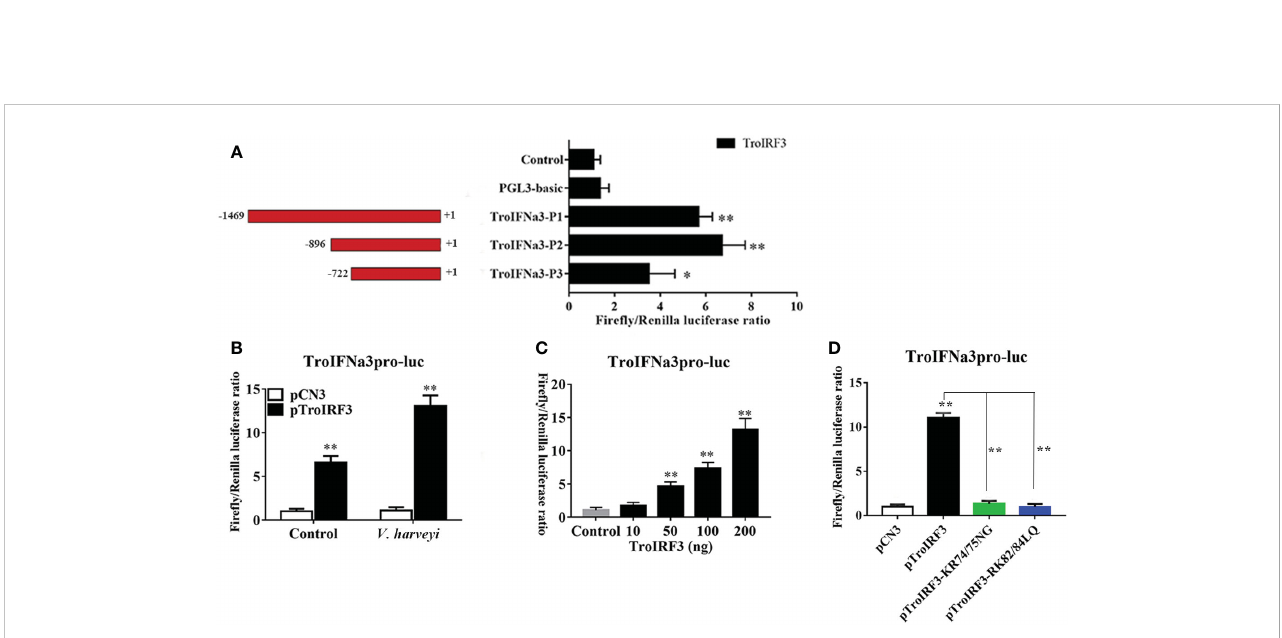
FIGURE 8 TroIRF3 regulated the activity of the TroIFNa3 promoter. (A) Three truncates of the TroIFNa3 promoter were constructed and transfected with pTroIRF3 into HEK 293T cells for 24 h, then harvested for detection of luciferase activity. (B) Activation of the TroIFNa3 promoter by TroIRF3. HEK293T cells seeded in 24-well plates were co-transfected with three plasmid sets: pCN3 (0.25 m g), pGL4-TroIFNa3-pro (0.25 m g), and pRL-TK; pTroIRF3 (0.25 m g), pGL4-TroIFNa3-pro (0.25 m g) and pRL-TK (0.025 m g). Cells were stimulated with or without V. harveyi after 24 h post-transfection, then harvested for detection of luciferase activity. (C) HEK293T cells seeded in 24-well plates were transfected with 0, 10, 50, 100, and 200 ng of pTroIRF3 along with pGL4-TroIFNa3-pro (0.25 m g) and pRL-TK (0.025 m g), then harvested for detection of luciferase activity. (D) The effect of NLS on TroIFNa3 promoter activation induced by TroIRF3. HEK293T cells seeded in 24-well plates were co-transfected with TroIFNa3 promoter (0.25 m g), as well as with pCN3, pTroIRF3, pTroIRF3-KR74/75NG, or pTroIRF3-RK82/84LQ (0.25 m g), plus 0.025 mg of pRL-CMV as an internal control. Cells were stimulated with V. harveyi for 12 h after 24 h post-transfection, then harvested for detection of luciferase activity. The values are represented as mean ± SD (N = 3). N, parallel experiments. * P < 0.05, ** P < 0.01.